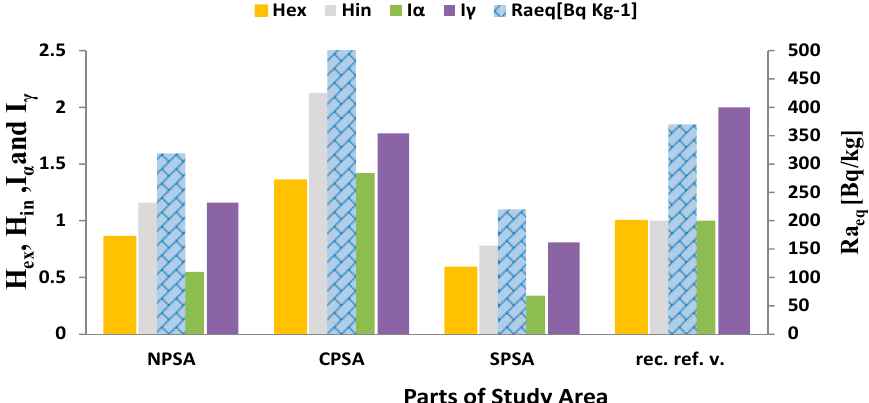
Figure 6. Average values of H ex , H in , I α , I γ and Ra eq in the three parts of the study area (compared to the worldwide averages).